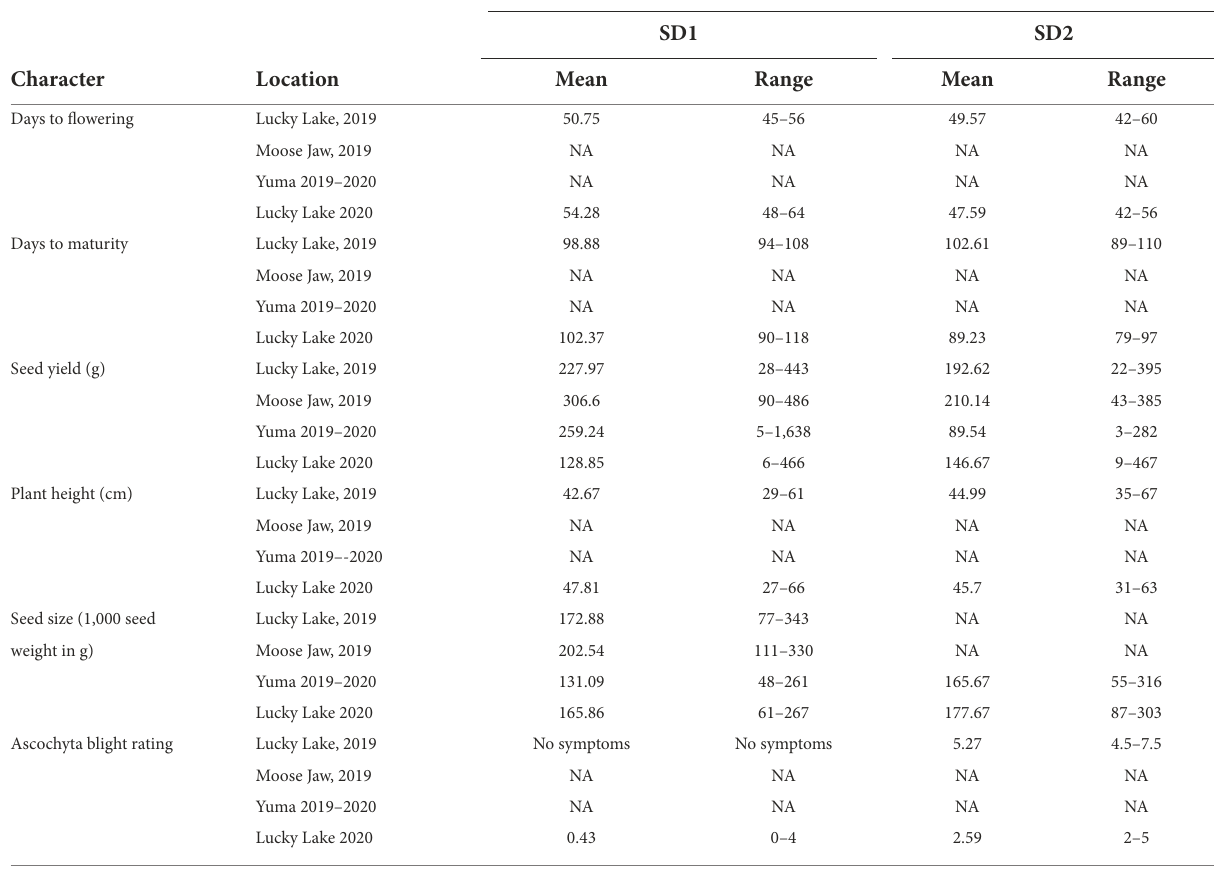
TABLE 2 Mean and range values of the interspecific population for characters assessed under field